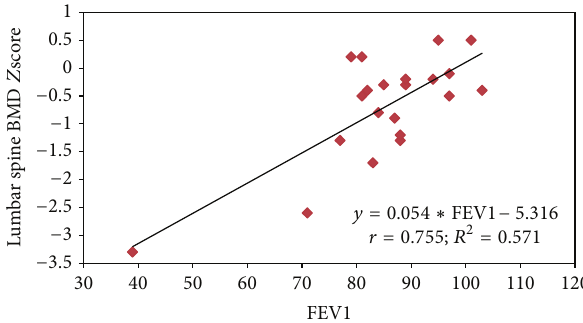
Figure 1: Relationship between lumbar spine BMD Z score and FEV1.